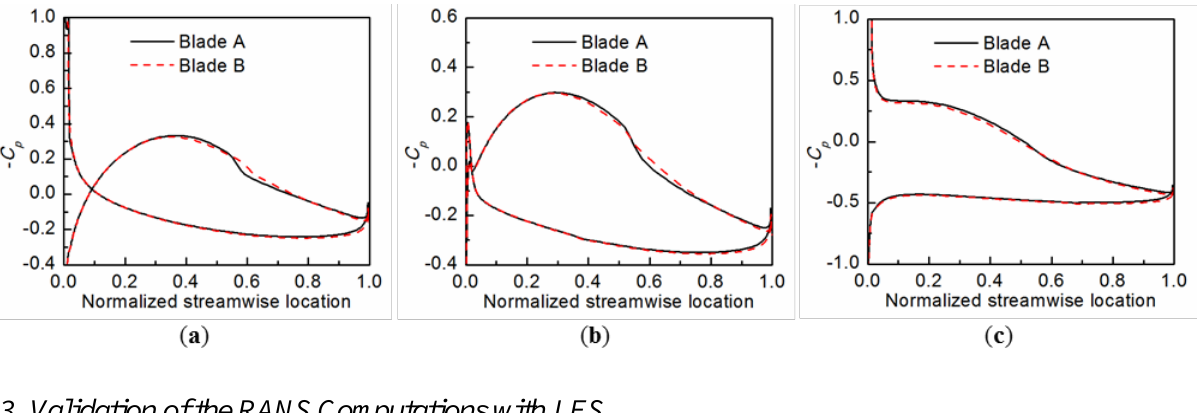
Figure 21. Pressure distributions of Blade A and B at different inlet flow angles: ( a ) α = 52°; ( b ) α = 55°; ( c ) α =